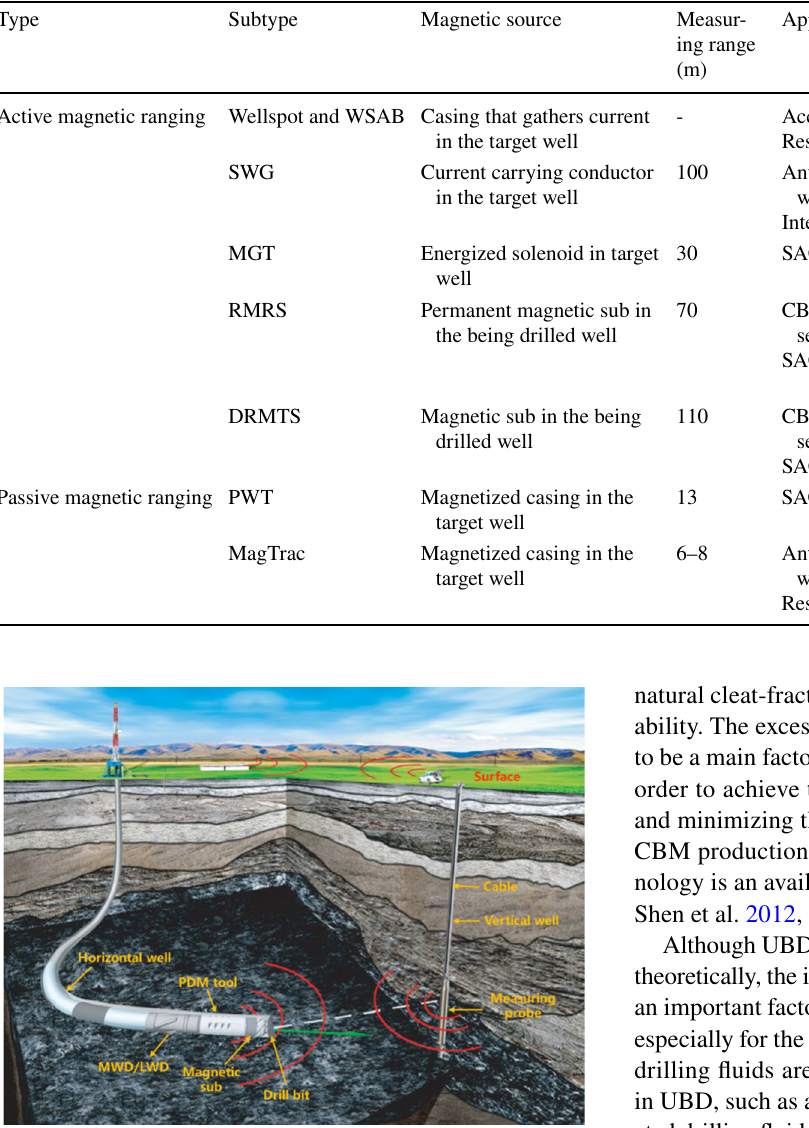
Fig. 23 Schematic of CBM magnetic guidance drilling using RMRS, modified from Gao and Diao